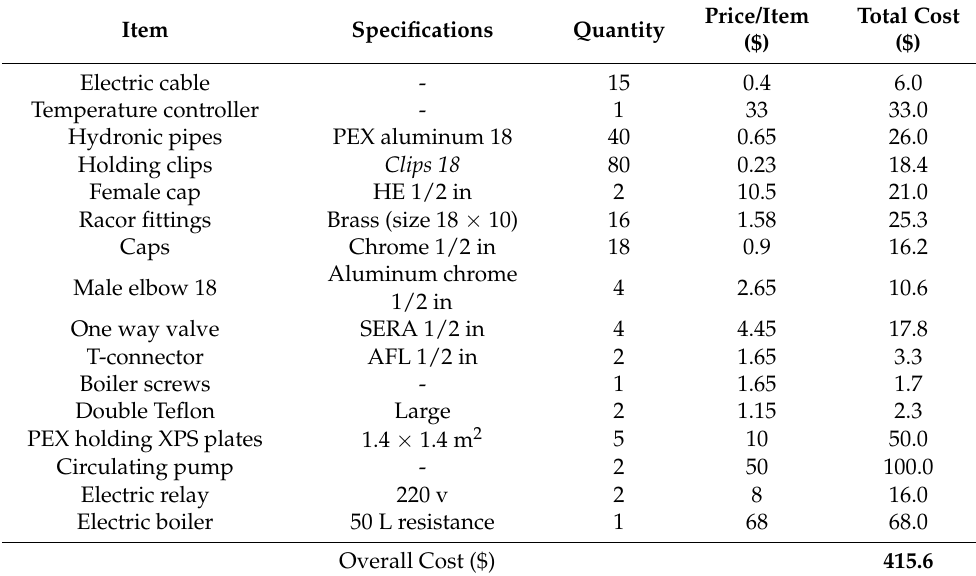
Table 8. Hydronic system specifications and respective